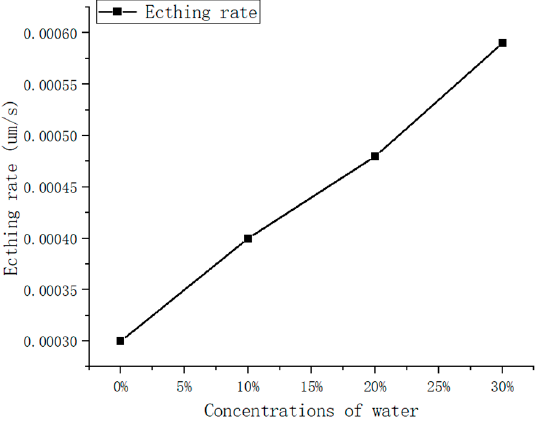
Figure 5. Etching rates under different water content conditions.